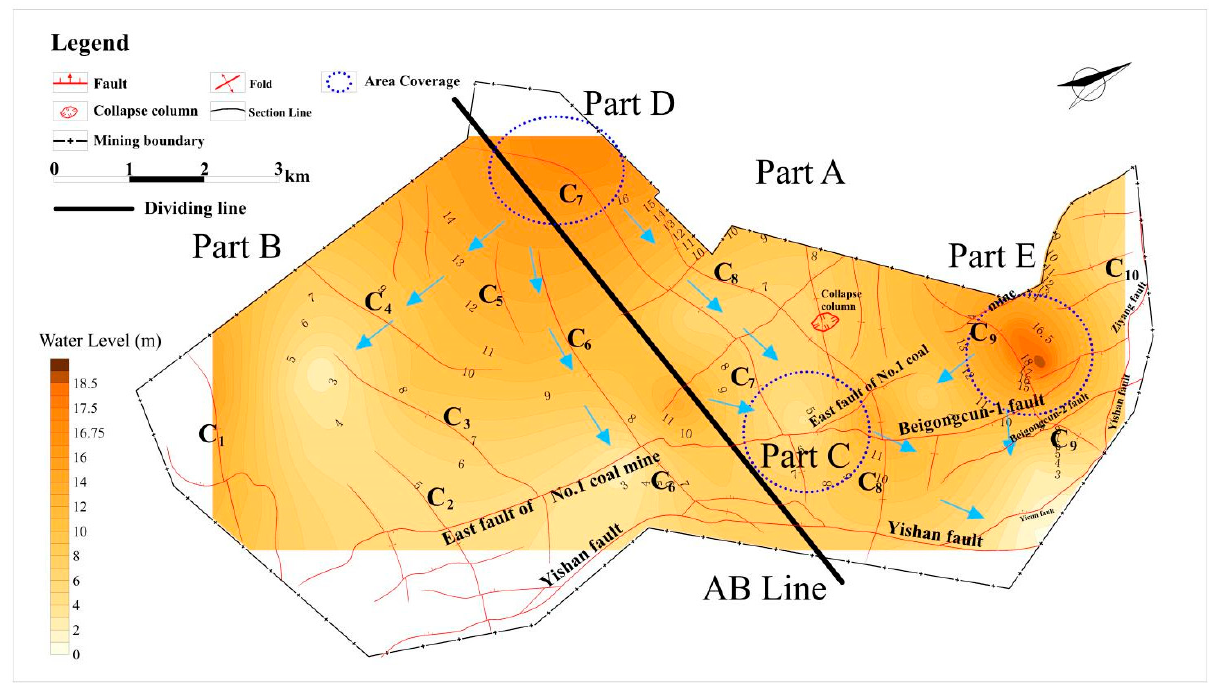
Figure 7. Water level Equivalent Diagram of the Ordovician aquifer in the Dongtan Coal Mine.